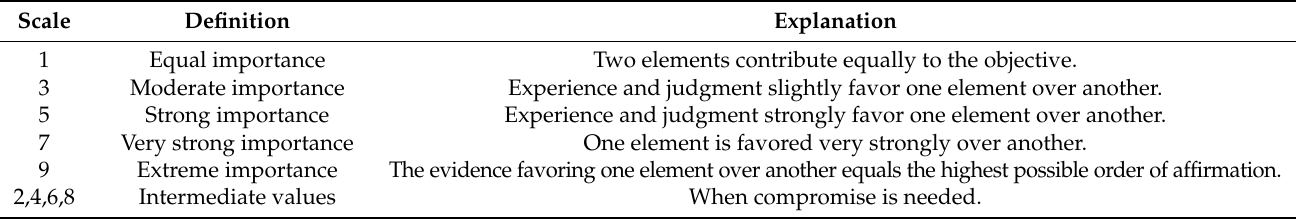
Table 2. Saaty’s scale of relative